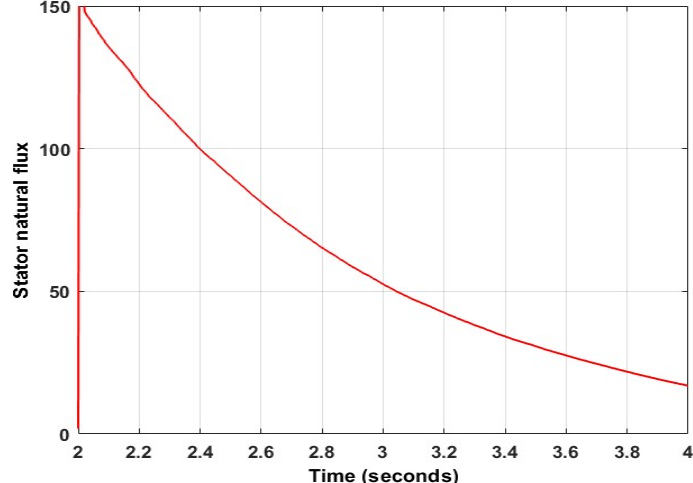
Figure 4. Stator natural flux for open-circuit rotor terminals.